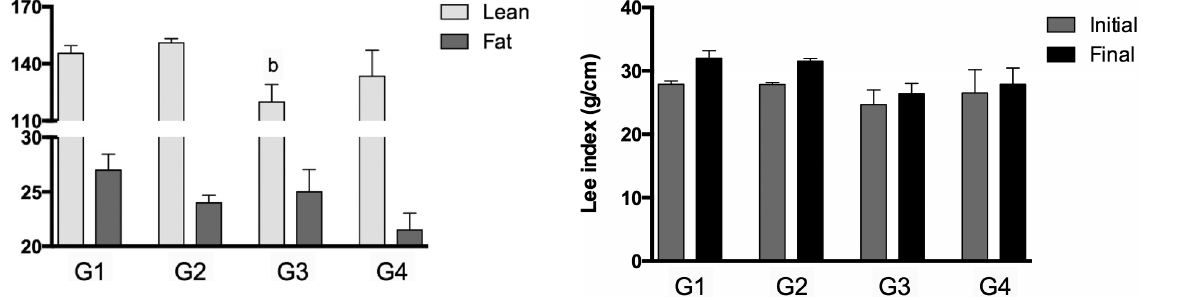
Biochemical analyses of non-exercised and exercised rats supplemented or not with coconut oil. Groups G1